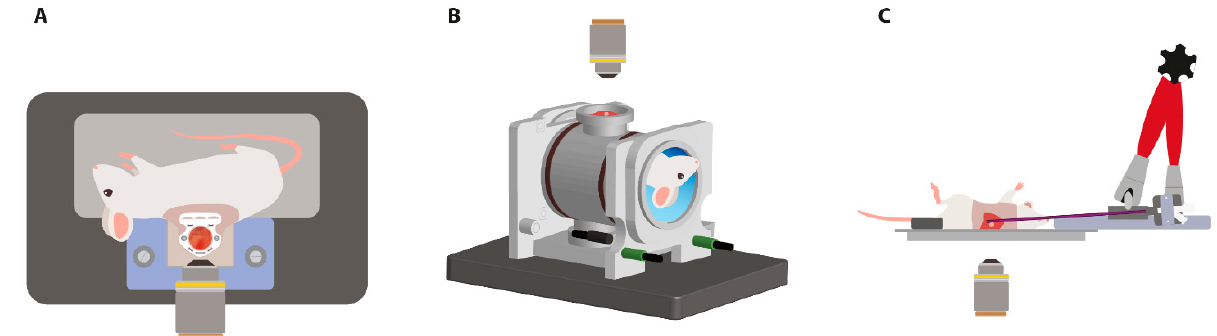
Figure 1. Illustrations of the devices for the application of local hyperthermia treatment in combination with intravital imaging. HT application occurs through ( A ) an external heating element adjacent to the dorsal skinfold chamber (Figure 2), ( B ) the generation of an oscillating electromagnetic field (Figure 3), and ( C ) the placement of the directional microwave hyperthermia system (Figure 4).